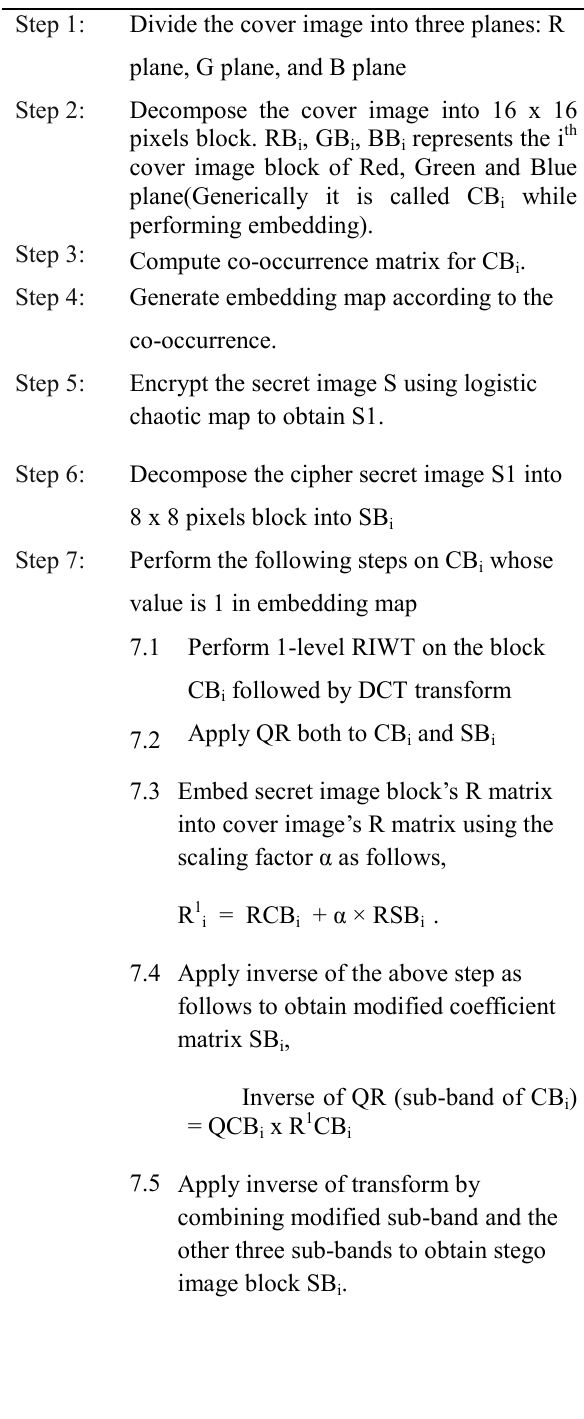
Pseudo code for Embedding